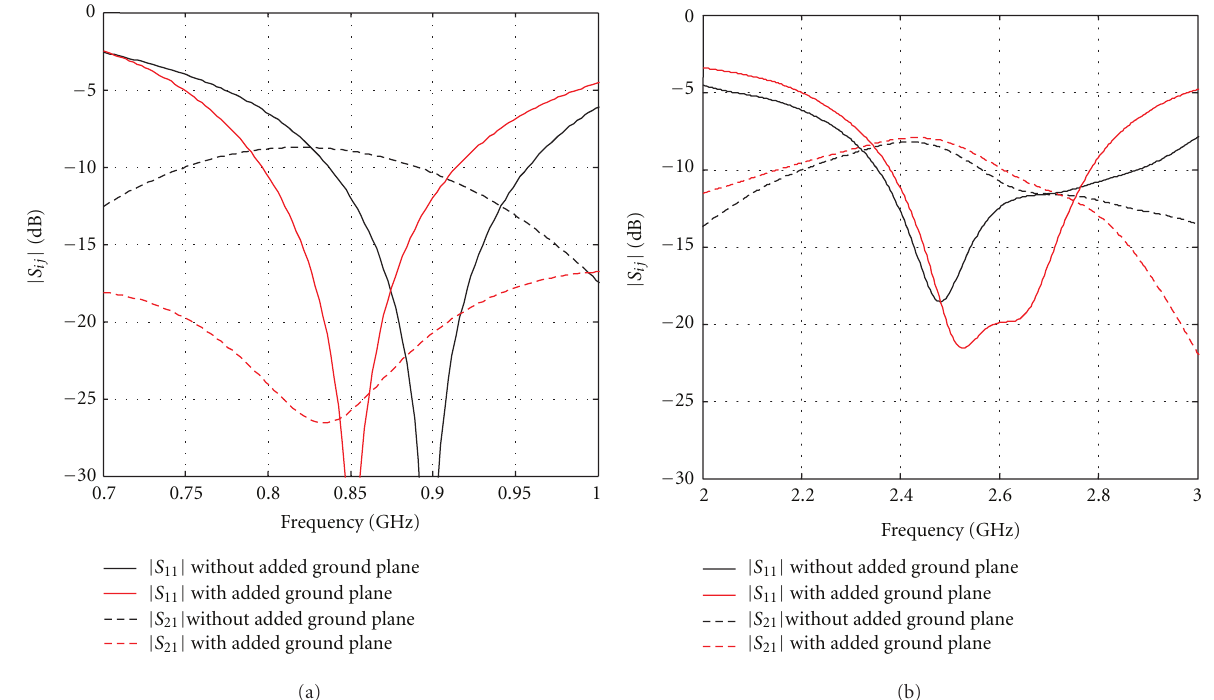
Figure 2: Simulated | S ij | parameters of one meander bend ending antennas without slot, with and without added ground plane: (a) lower band, (b) higher